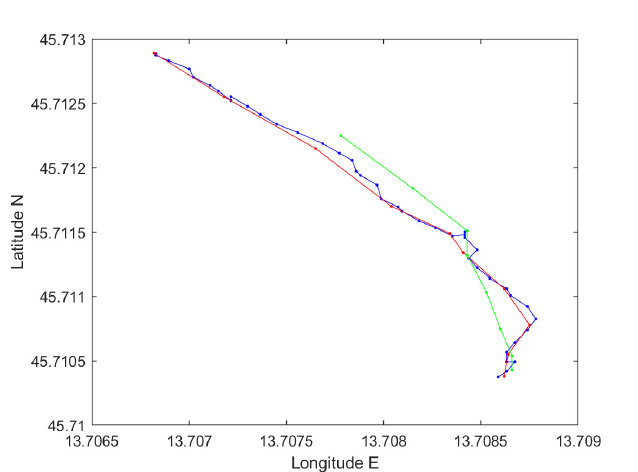
Figure 8. Drifter trajectories during the second phase of the experiment carried out in March 2018 (blue = Drifter 1 - LoRa data; red = Drifter 1 - SPOT data; green = Drifter 2 - SPOT data)